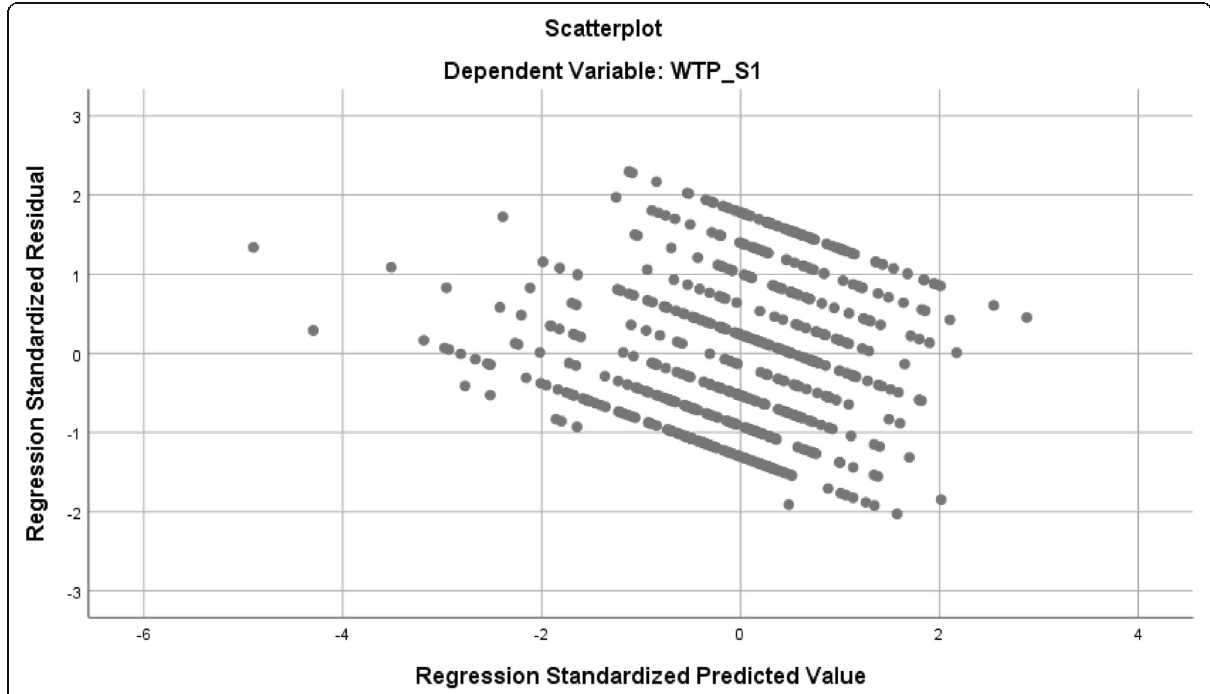
Fig. 13 Scatterplot of residuals versus predicted values of Model A